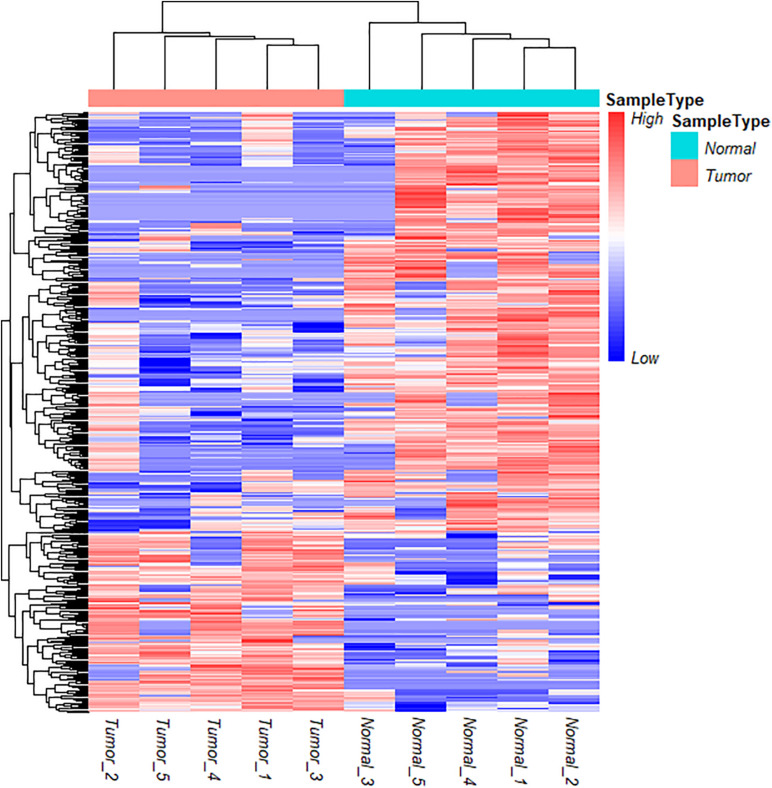
Cluster analysis of circRNA full-length transcripts with significant difference expression in tumor and adjacent samples in cervical cancer.